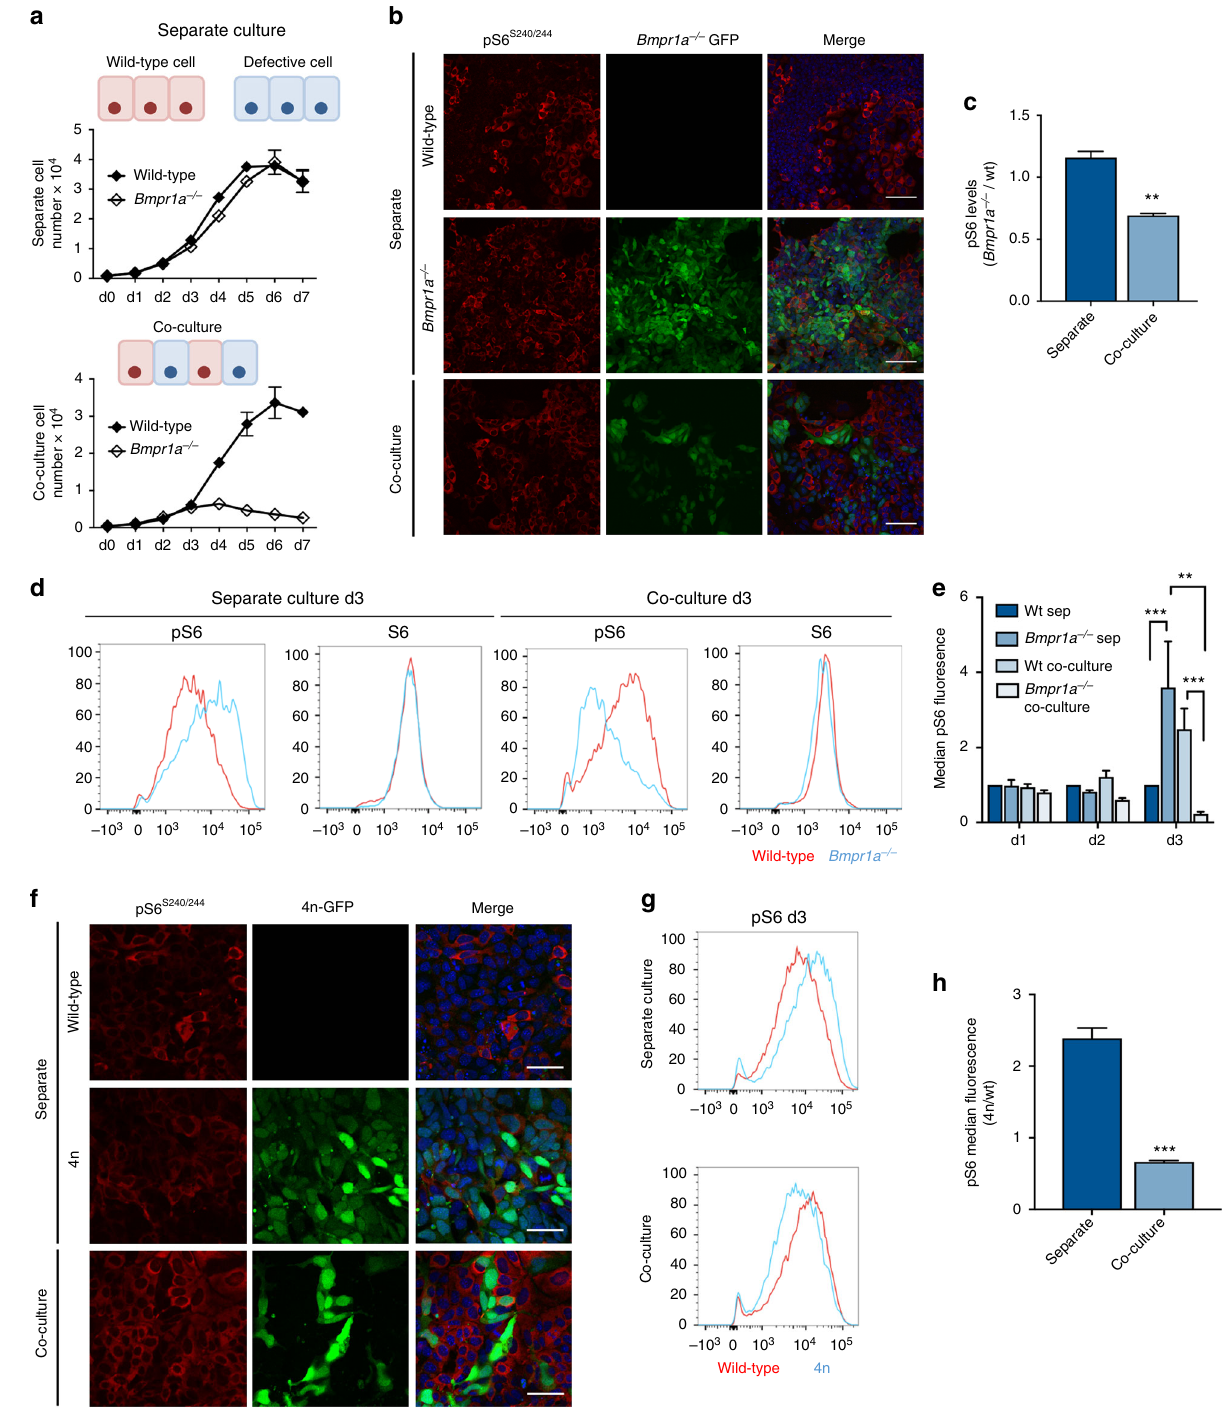
Fig. 1 Reduced levels of mTOR pathway activity in defective cells during cell competition. a Growth curves of wild-type and Bmpr1a − / − cells over 7 days in separate and co-culture. b Phospho-S6 S240/244 levels in wild-type and Bmpr1a − / − cells cultured separately and together were assessed by immuno fl uorescence analysis and quanti fi ed ( c ). Scale bar = 200 μ m. d Total (S6) and phospho-S6 (pS6) levels in wild-type and Bmpr1a − / − cultured separately and together were assessed by fl ow cytometry, and the median fl uorescence of Bmpr1a − / − /wild-type cells was compared in separate and co- culture over the fi rst three days in competition ( e ). f Levels of pS6 S240/244 in wild-type and tetraploid (4n) cells after three days in competition were assessed by immuno fl uorescence. Scale bar = 50 μ m. g Levels of pS6 S240/244 levels in wild-type and 4n cells after three days in competition were assessed by fl ow cytometry and the median fl uorescence of 4n/wild-type cells was compared in separate and co-culture at day three days of competition ( h ). n > 3; error bars denote standard error of the mean (SEM). ** p < 0.01 and *** p < 0.005; unpaired, two-tailed t -test ( c , h ) or ANOVA and Tukeys